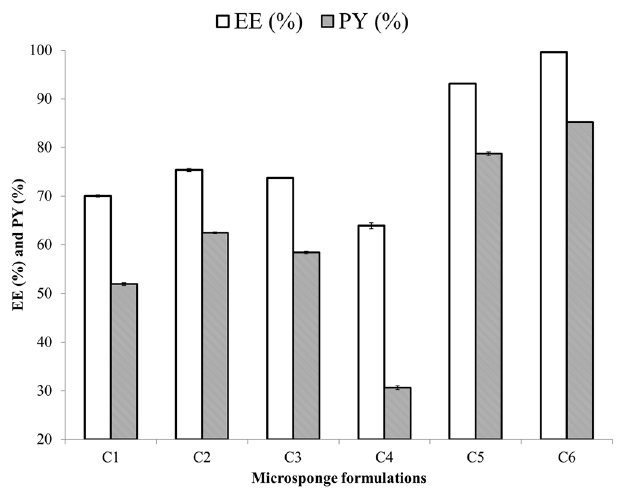
Figure 1. Graph Showing EE (%) and PY (%). Data are expressed as mean ± SD (n =